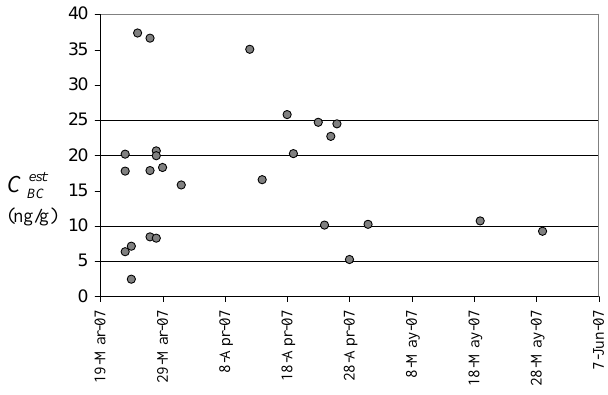
Fig. 14. Time-series of BC concentrations in newly fallen snow at Ny- ˚Alesund, Svalbard (79 ◦ N, 12 ◦ E), in 2007.